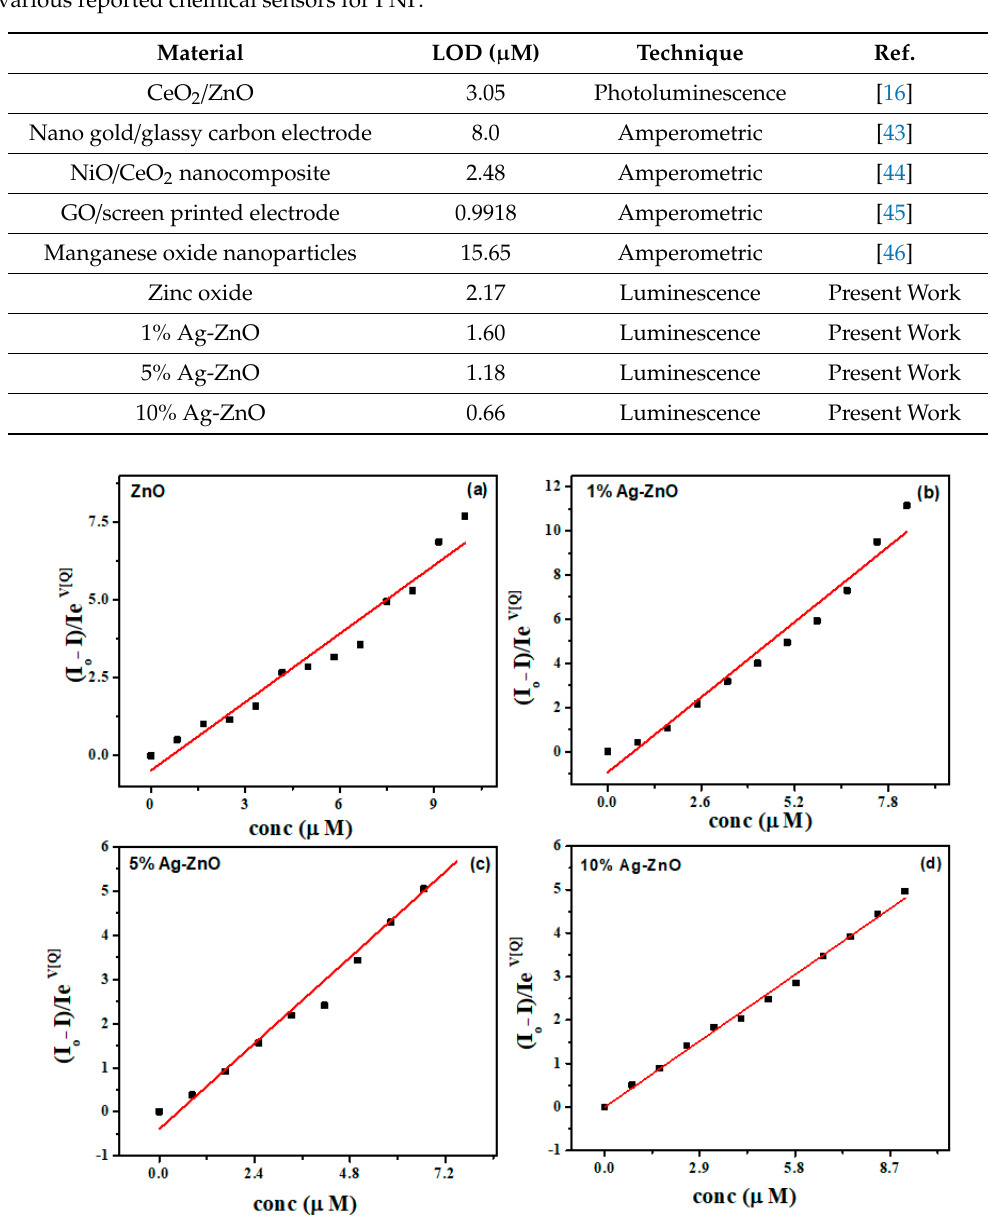
Figure 10. Modified Stern–Volmer plots of ( a ) ZnO, ( b ) 1% Ag-ZnO, ( c ) 5% Ag-ZnO and ( d ) 10% Ag doped ZnO nanostructures.